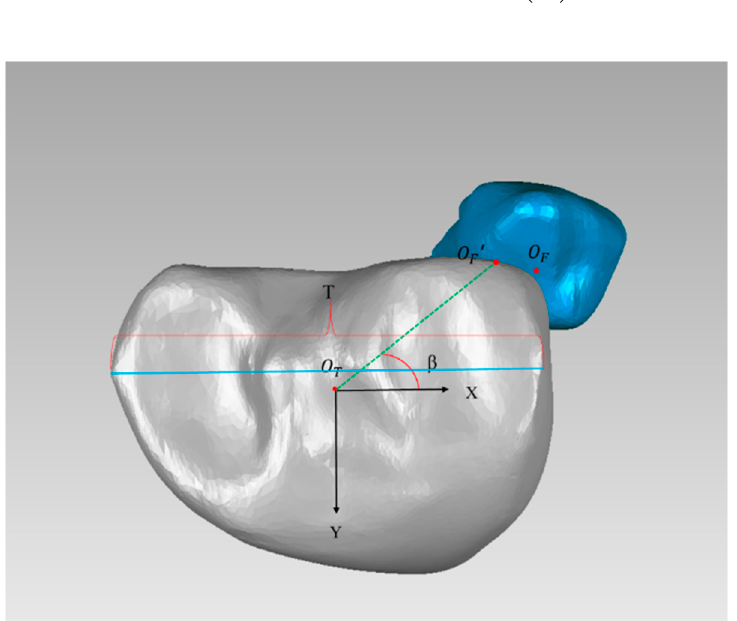
Figure 1. Measurement of the declination angle β . ( O T is the center of tibial plateau and was used as the origin of the tibial coordinate system. The Z axis was determined using a line connecting the center of the tibial plateau to the center of the distal tibial articular surface, with the positive direction running from proximal to distal. The Y axis ran from posterior to anterior, and the X axis ran from medial to lateral. O F was designated as the centroid of the articular surface on the fibular side. T was the largest medial-lateral width of the tibial plateau. The articular declination angle β was the angle between O T O F (cid:48) and the X axis. O F (cid:48) was the projection of O F in the XY